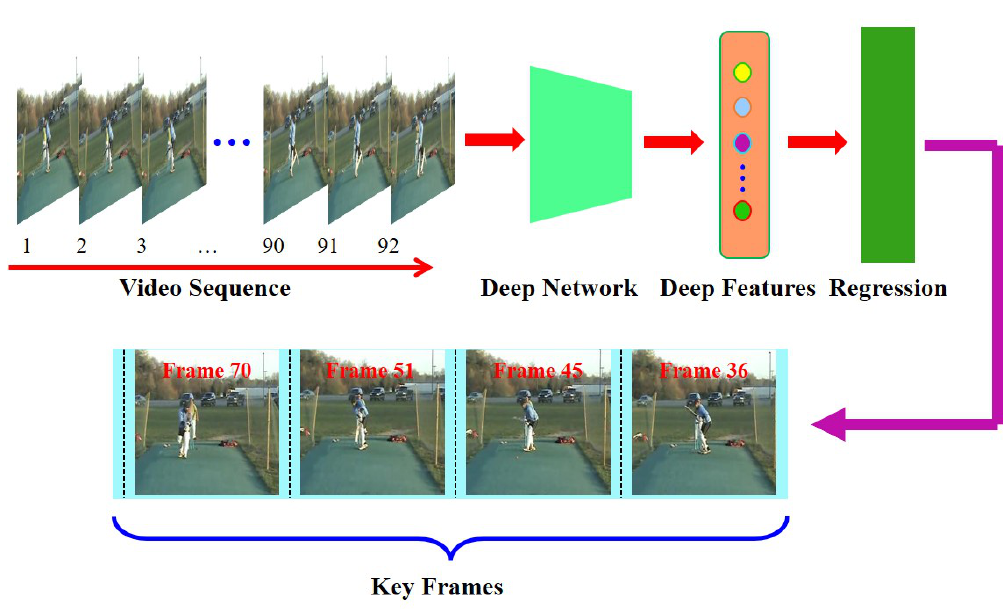
Figure 1. Conceptual overview of our approach . The proposed method automatically annotates key frames as the discriminant frames in a video to avoid the time-consuming and subjective manual labelling. Discrimnant analysis is performed on the framewise features extracted using a pretrained CNN. This example is of “Cricket Shot” with 92 frames. Our method marks four frames as key frames. Note that these four key frames can still describe the class of the human